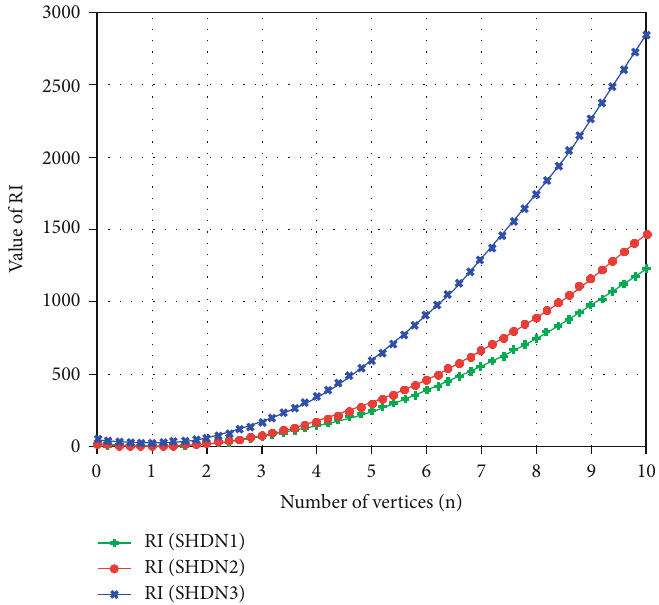
n Þ , Γ n Þ , and Γ n Þ using 2D graphs of Randi c ′ index. 1 ð 2 ð 3 ð